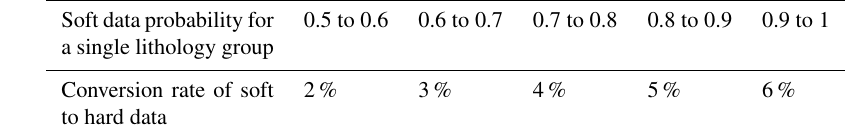
Table 4. Conversion rates for soft data in the conditional realization.